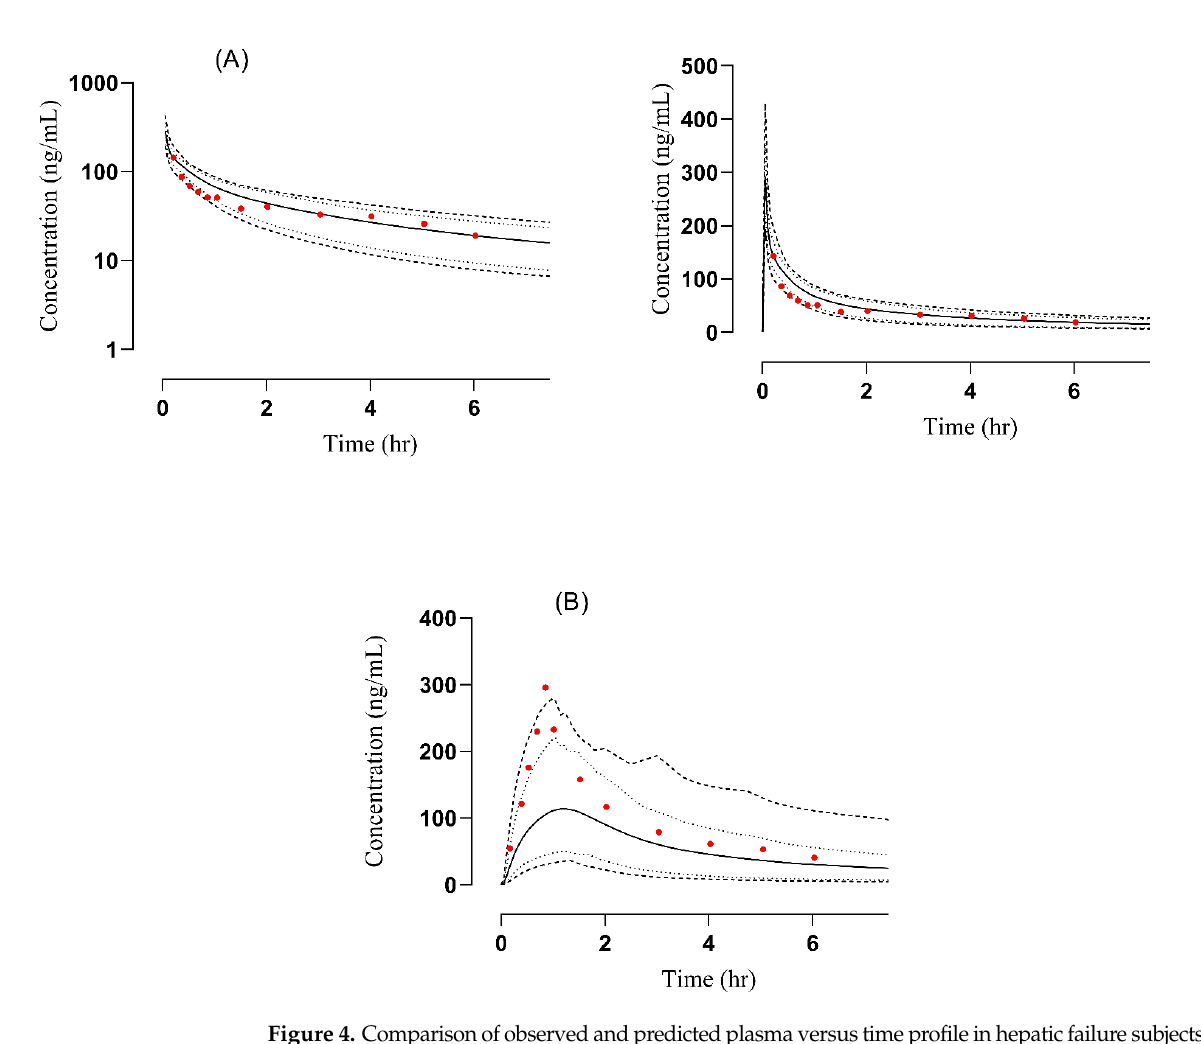
Figure 4. Comparison of observed and predicted plasma versus time profile in hepatic failure subjects after IV ( A ) [26] and oral ( B ) [26] administration at a dose of 0.5 mg/kg and 200 mg, respectively. The solid line [—] indicates the arithmetic mean, dash line [- - - -] maximum and minimum, the dotted line [....] 5th–95th percentile, red dots indicate observed data, and the solid line indicated predicted data.